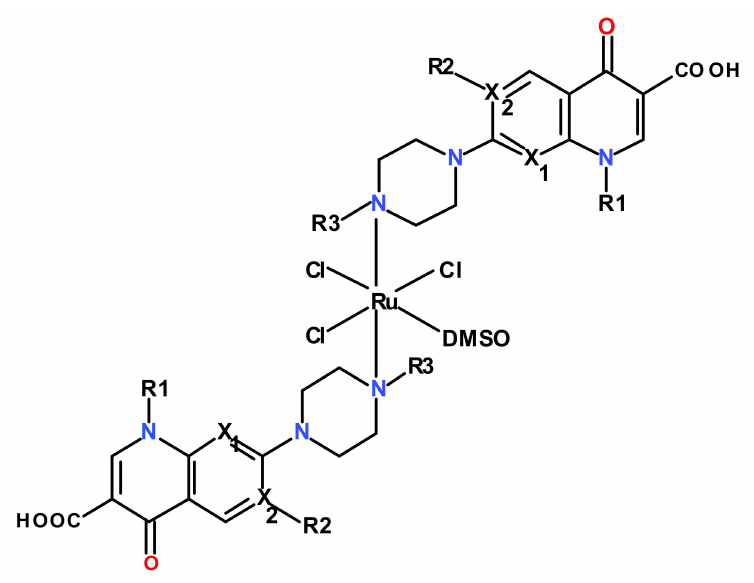
Figure 1. Structures of the investigated Ru(III) complexes with